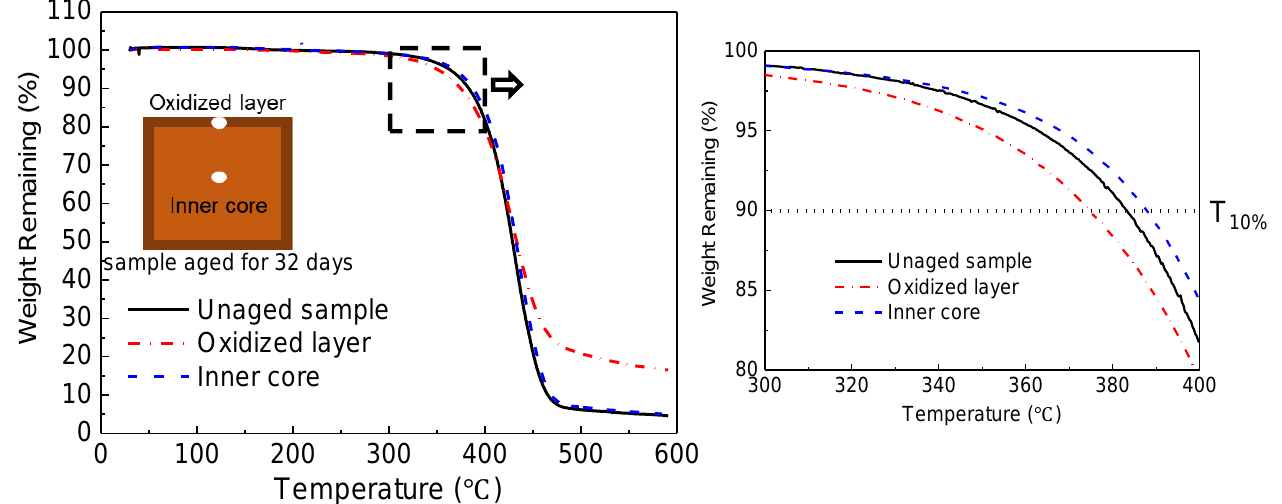
Figure 8. Thermogravimetric analysis.